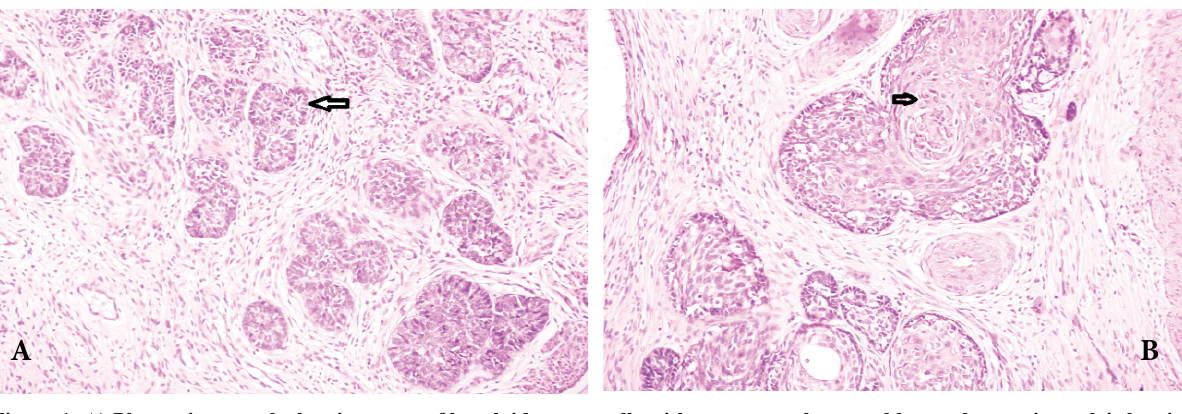
Figure 1: A) Photomicrograph showing nests of basaloid tumor cells with scant cytoplasm and hyperchromatic nuclei showing peripheral nuclear palisading (arrow). B) Photomicrograph showing squamoid differentiation (arrow) in between tumor cells. (HE stain; 100X)